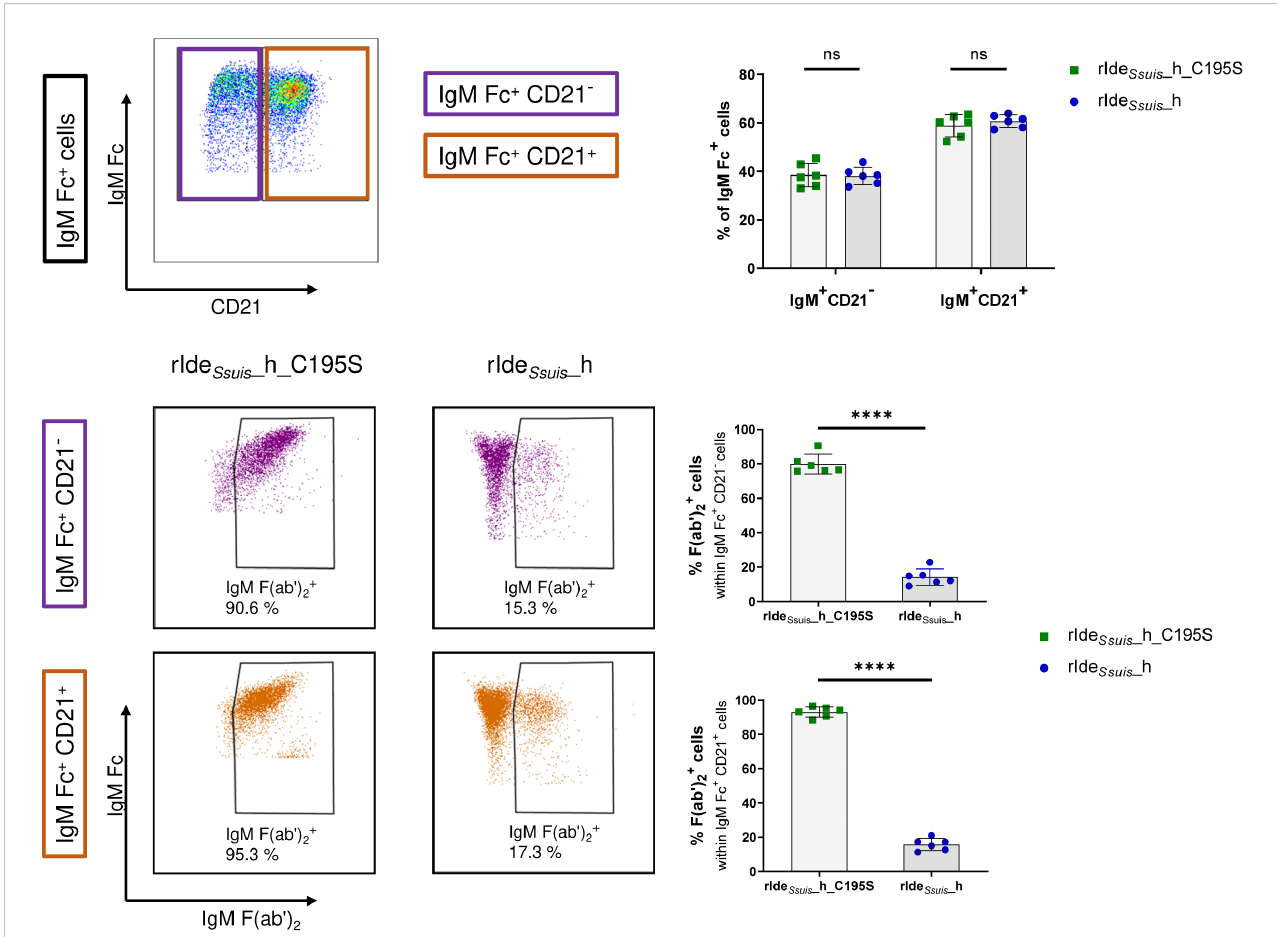
FIGURE 4 rIde Ssuis _homologue cleaves the IgM B cell receptor on CD21 + B2 cells and CD21 - cells. IgM + cells in porcine PBMCs of 8-week-old piglets can be discriminated by CD21 expression (upper panels). Both IgM + CD21 - B1-like cells (middle panels) and IgM + CD21 + B2 cells (lower panels) show signi fi cant IgM BCR cleavage by rIde Ssuis _homologue (rIde Ssuis _h) (4 µg/1x10 6 cells, 45 min, 37°C) compared to rIde Ssuis _homologue_C195S (rIde Ssuis _h_C195S). Pre-gating of IgM Fc + cells was performed as described in Figure 1A. Statistical analyses were conducted with unpaired t-test (n = 6, p > 0.05 ns, p < 0.0001